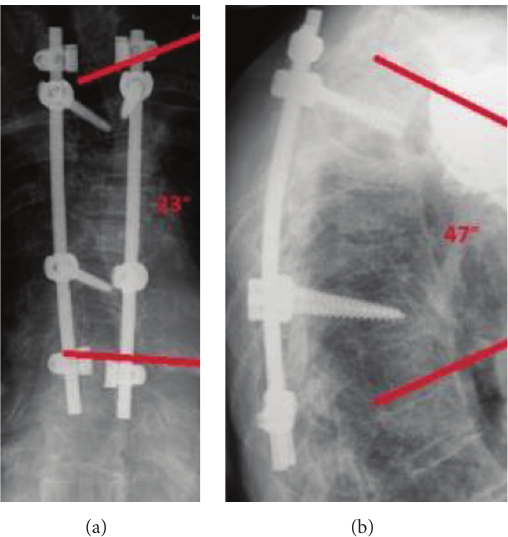
Figure 4: (a) Postoperative result with pedicle screws in T2 and T6 and UC System in T1 and T7 (12 months). Cobb angle (T1–7): 23 ∘ . (b) Postoperative result lateral (12 months). Kyphosis angle (T1–7): 47 ∘